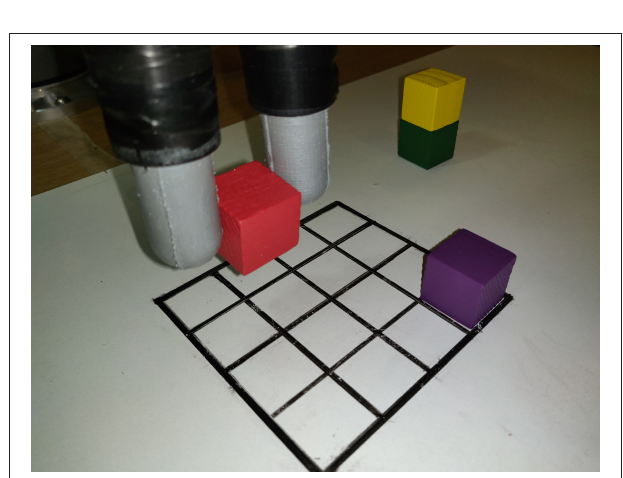
FIGURE 10 | The Blocks World experimental setup. In each experiment, the robot actuator moves row by row, attempting to grasp each block. The experiment shows that, even with the initial uncertainty, the robot grasps all the blocks successfully using the all-around touch feedback.